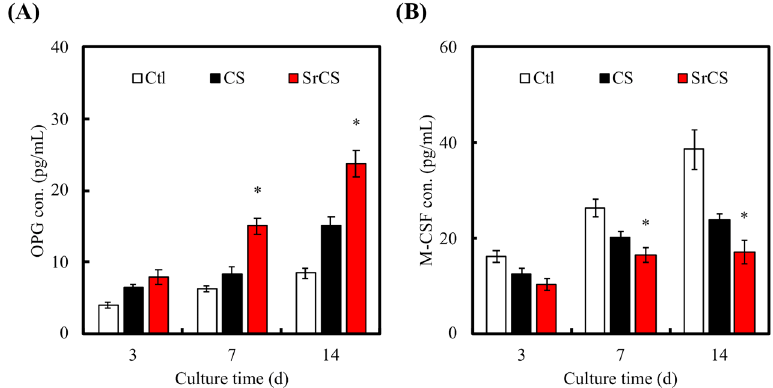
Figure 11. Proteins of ( A ) OPG and ( B ) M-CSF secretion by MSCs were measured by enzyme-linked immunosorbent assay. Data presented as mean ± SEM, n = 6 for each group. “*” indicates a significant difference ( p < 0.05) when compared to CS scaffold. “Ctl” represented cells that grew in empty wells without any scaffolds.